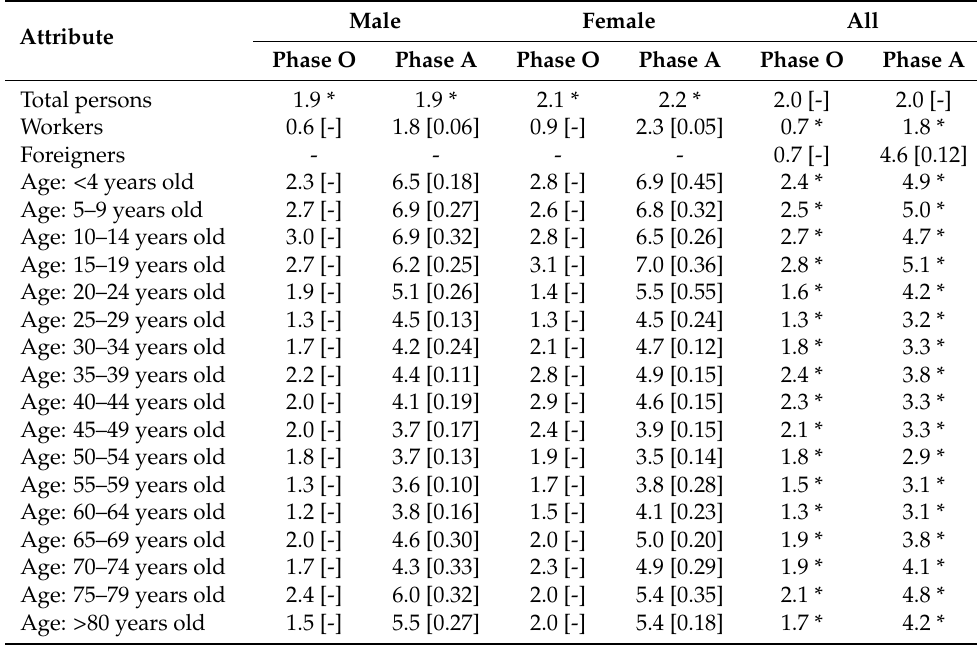
Table 4. Weighted average error and standard deviation for person